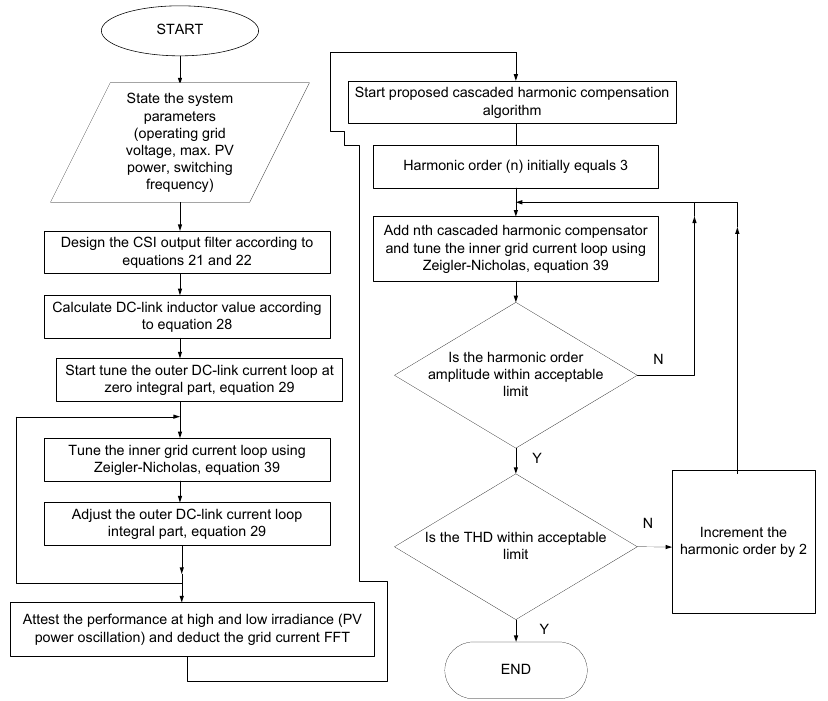
Figure A1. Step-by-step design guidance.